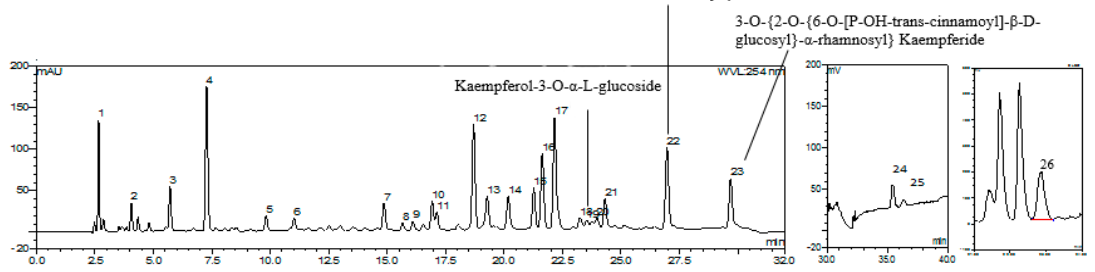
Figure 6. Three core bioactive compounds of GBE related to ET-1.